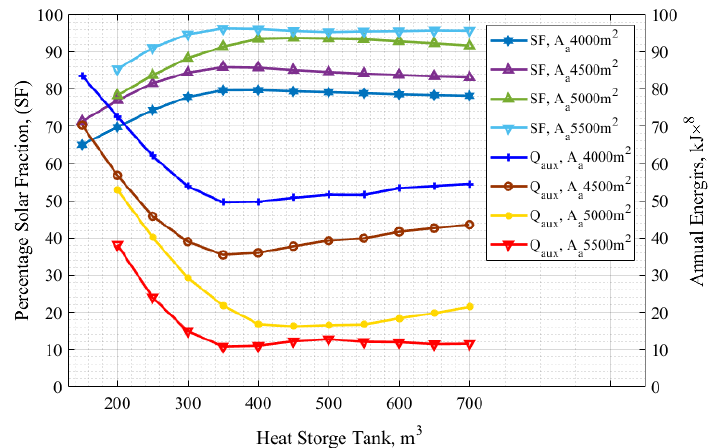
Figure 12. The solar fraction and annual auxiliary energy need vs the storage tank size for different solar field